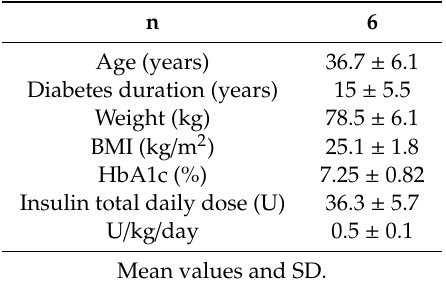
Table 1. Characteristics of subjects at